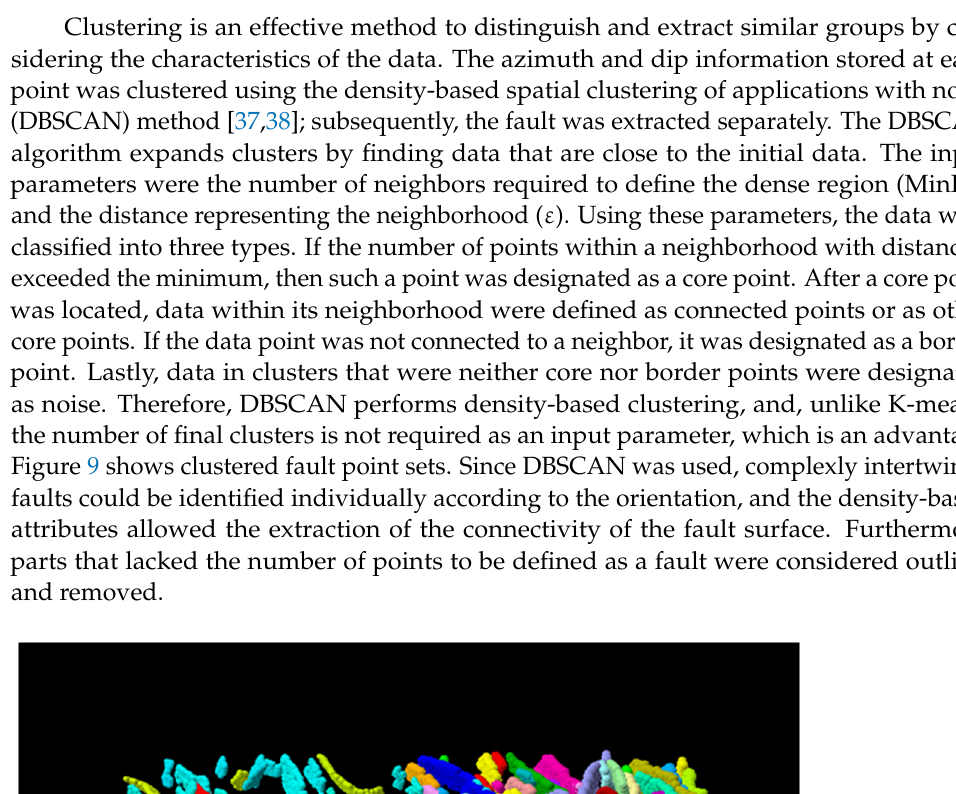
Figure 8. Extracted fault surfaces as ( a ) point type. To perform orientation clustering, ( b ) azimuth and ( c ) dip information for each point position was also extracted.